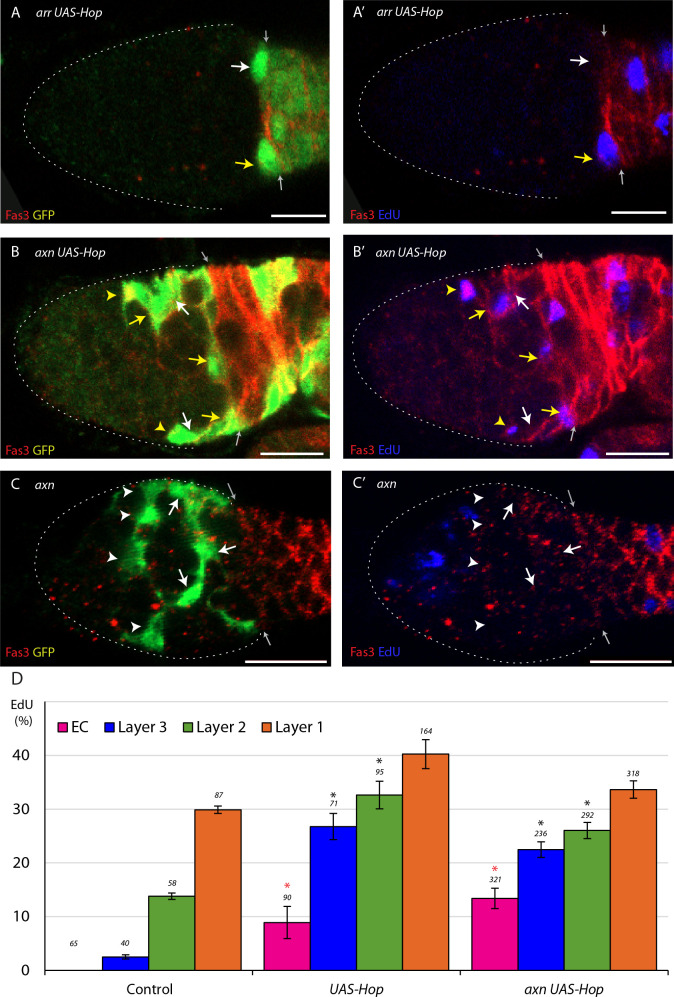
Increased JAK-STAT signaling promotes FSC division even when Wnt pathway activity is altered.(A–C) EdU (blue) incorporation into MARCM FSC lineages 6d after clone induction with anterior border of Fas3 (red) marked (gray arrows), showing (A–C) GFP and (A’–C’) EdU channels separately. The proportion of marked FSCs with EdU (yellow arrows) compared to those without EdU (white arrows) was (A, B) higher than controls for arr and axn genotypes with UAS-Hop and (C) lower than controls for axn with no alteration of JAK-STAT signaling. All scale bars are 10 μm. (D) EdU incorporation frequency at 6d after heat shock into FSCs of layers 1–3 and ECs for the indicated genotypes of MARCM lineages with number of cells scored above each column and significant differences from control values (black asterisks, p<0.05, red asterisks, p<0.001). These experiments were performed at 22°C so that UAS-Hop expression was lower than for results shown in Figure 5. Only experiments for axn UAS-Hop performed at 22C could be scored for FSC numbers at 12d (data presented in Figure 6H).Figure 5—figure supplement 3—source data 1.Numerical data for graphs in Figure 5—figure supplement 3.